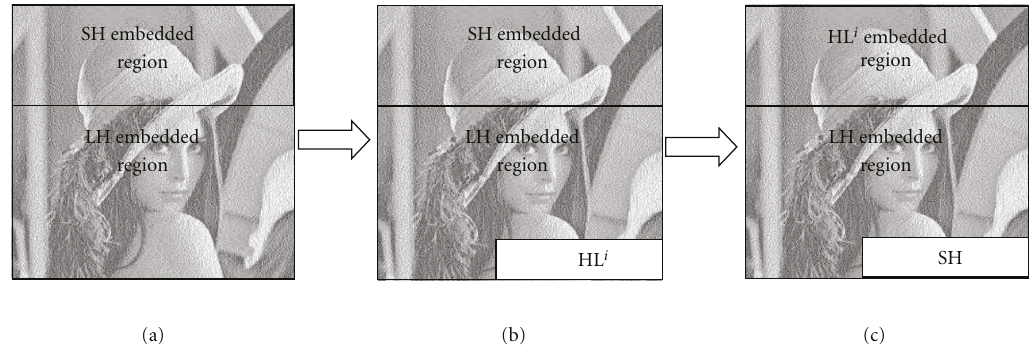
Figure 10: The flowchart of data embedding process: (a) embed SH and LH into the halftone image in horizontal scanning, and generate a stego image S ; (b) extract data from the last row of stego image S , and denote it as HL i ; (c) HL i is then embedded into the stego image S with pair-based method, and generate another stego image S (cid:4) .